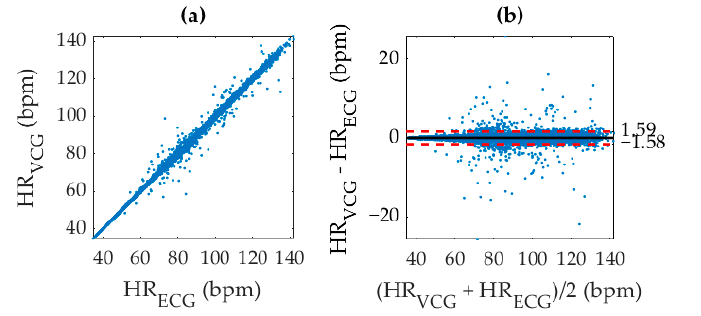
Figure 7. ( a ) Correlation of VCG aortic opening (AO) identification with ECG R peak identification to produce an r 2 value of 0.9982, and ( b ) corresponding Bland-Altman plot. The (black, solid) mean difference, and (red, dashed) 95% limits of agreement are shown overlaid.